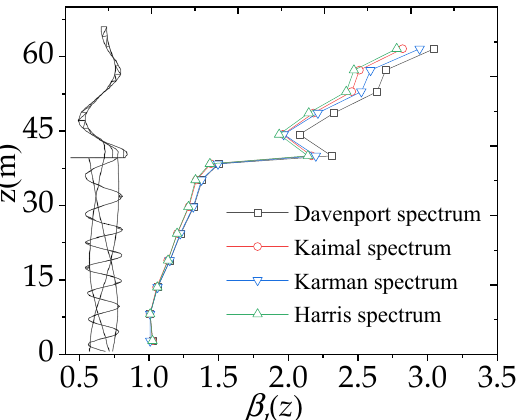
Figure 8. Comparison of wind-induced vibration coefficients among different wind speed spectra.